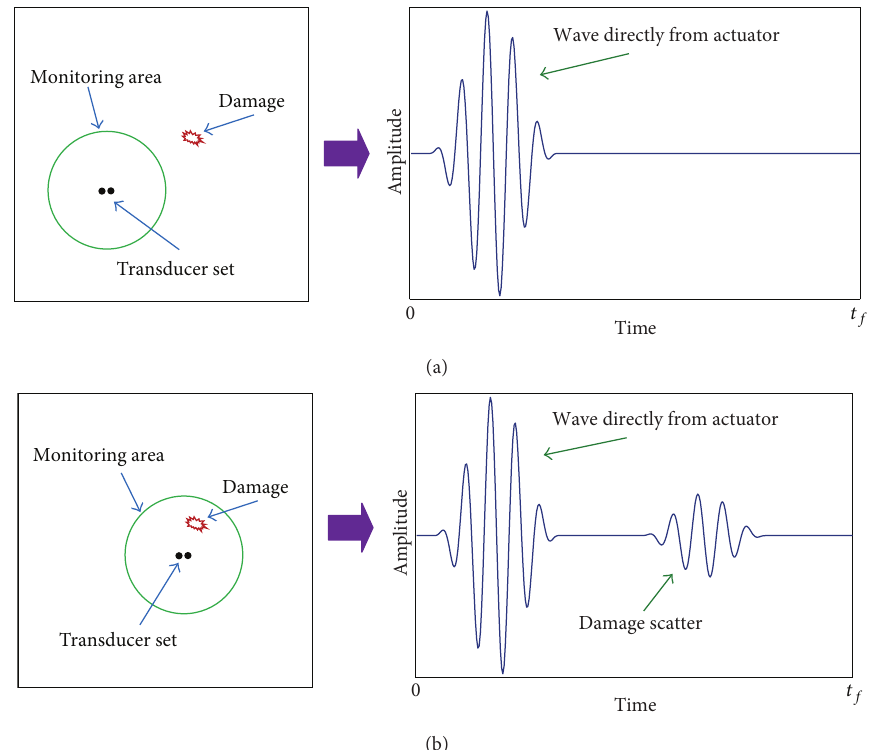
Figure 3: Diagnostic approach: (a) signal captured at monitoring area without damage; (b) signal captured at monitoring area with damage.